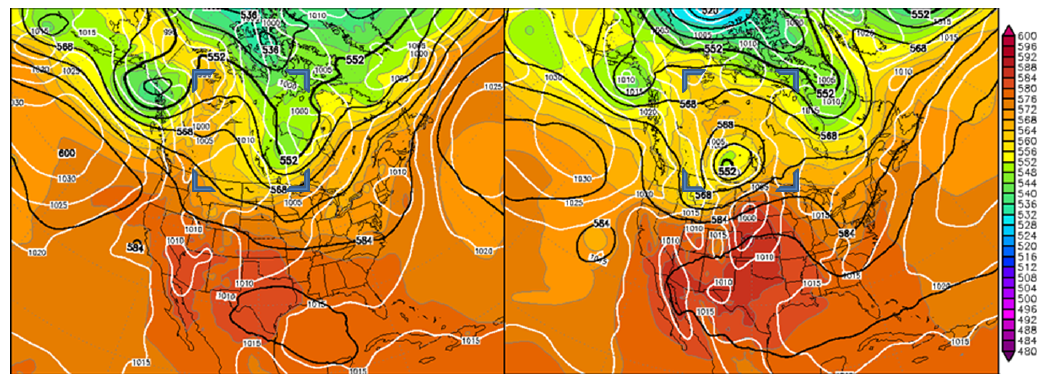
Figure 7. Reanalysis (climate forecast system, CFS) of the meteorological conditions on 11 July 2010 at 18:00UTC (left) and 14 July 2010 at 6:00UTC (right), 500hPa geopotential (gpdm) black lines, surface pressure (hPa) white lines and relative topography H500-H1000 (gpdm) color coding (www.wetter3.de). The edges of the simulation domain are indicated with blue triangles.